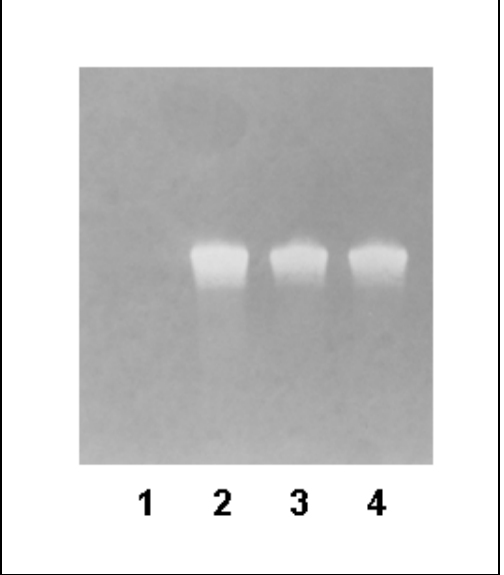
Figure 1. Detection of biotinylated DNA strand by modified Western